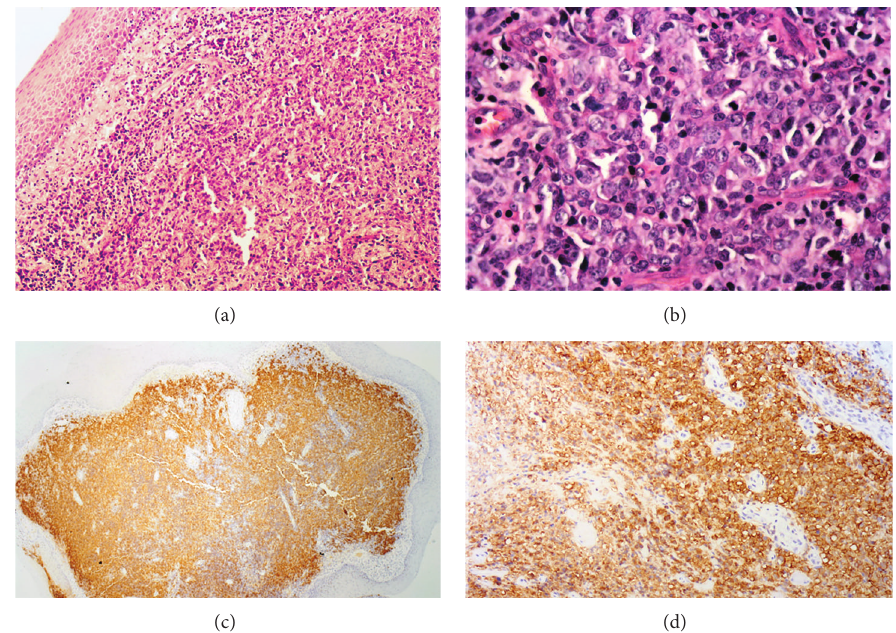
Figure 2: Infiltrate of vocal cord by large lymphoid cells on H&E ((a) and (b)), positive for CD20 ((c) and (d)) on immunohistochemistry.